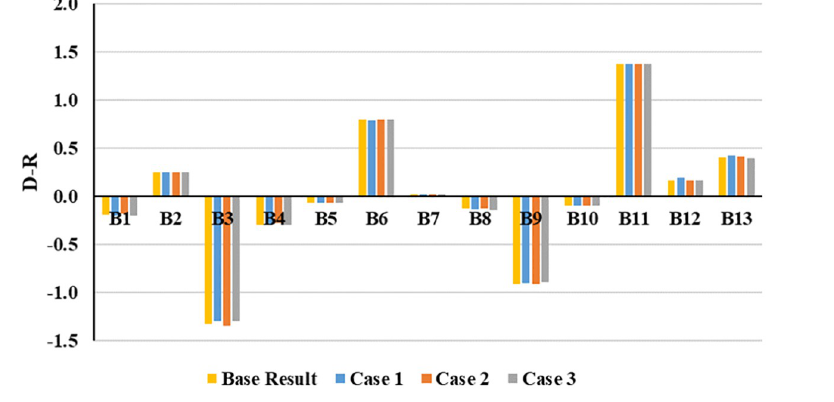
Fig 10. Comparison of different cases and base